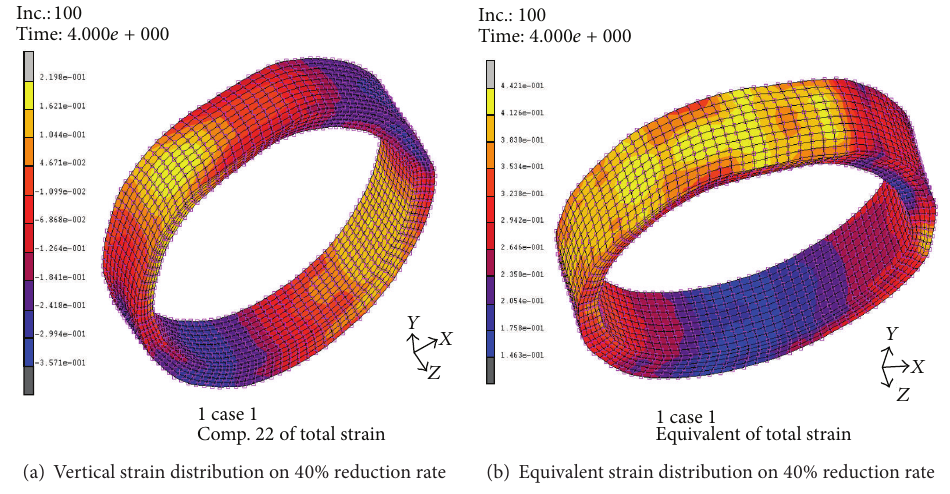
Figure 3: Vertical strain and equivalent strain distribution in deformation zone.